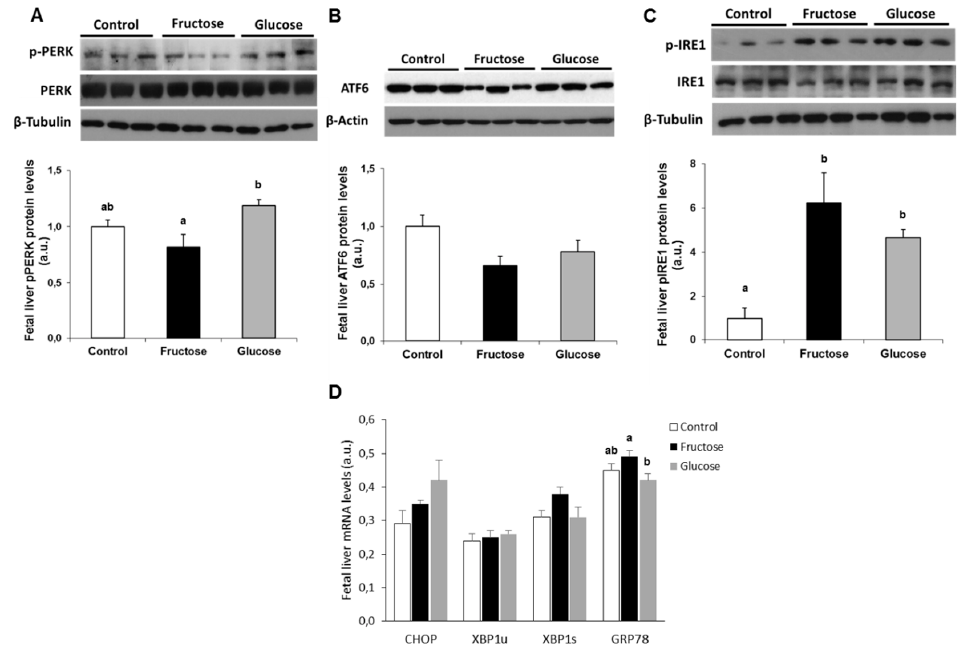
Figure 2. Maternal ingestion of a 10% w/v fructose solution throughout gestation affects ER-stress in fetal liver. Bar plots showing ( A ) the ratio between Thr-phosphorylated form, and the total PERK, ( B ) total ATF6, and ( C ) the ratio between Ser-phosphorylated form, and the total IRE1 proteins in fetal hepatic samples of control (empty bar), fructose- (black bar), and glucose-fed (grey bar) pregnant rats. Values were normalized to β -actin or β -tubulin levels and expressed in arbitrary units (a.u.). ( D ) Bar plots showing the relative hepatic levels of specific mRNA for target genes controlled by the three branches of the unfolded protein response (UPR) from fetuses of control, fructose, and glucose pregnant rats. Results are the mean ± S.E. of values from 6–7 fetal liver pools of the same litter for mRNA gene expression and 5 samples for protein expression. Values not sharing a common letter are significantly different at P < 0.05.